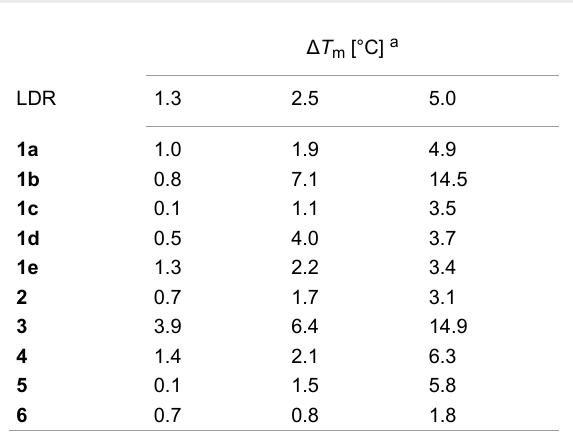
Table 1: Shifts of melting temperature, Δ T m, of quadruplex-DNA Fa2T induced by ligands 1 – 6 as determined from fluorimetric thermal DNA denaturation